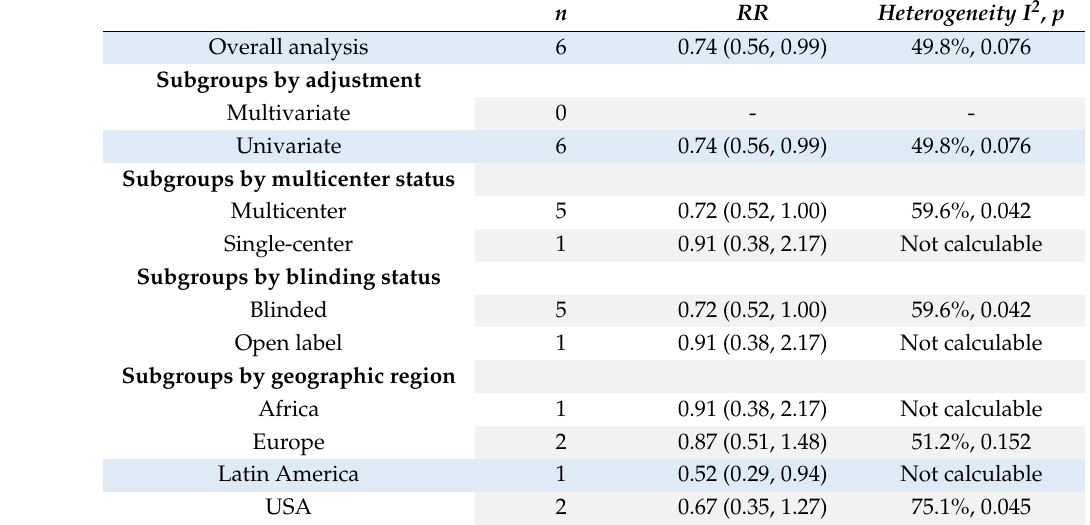
Table 7 Results of the meta-analyses examining the association between convalescent plasma therapy and hospitalization outcomes (28-day); subgroup analyses by adjustment, multicenter status, blinding status and geographic region are presented. Highlighted rows denote statistically significant associations.